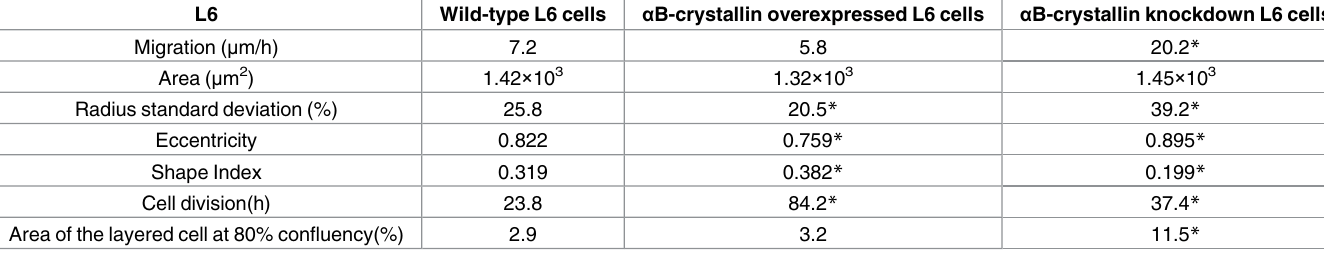
Table 2. α B-crystallindependent cell characteristics in rat L6 myoblast